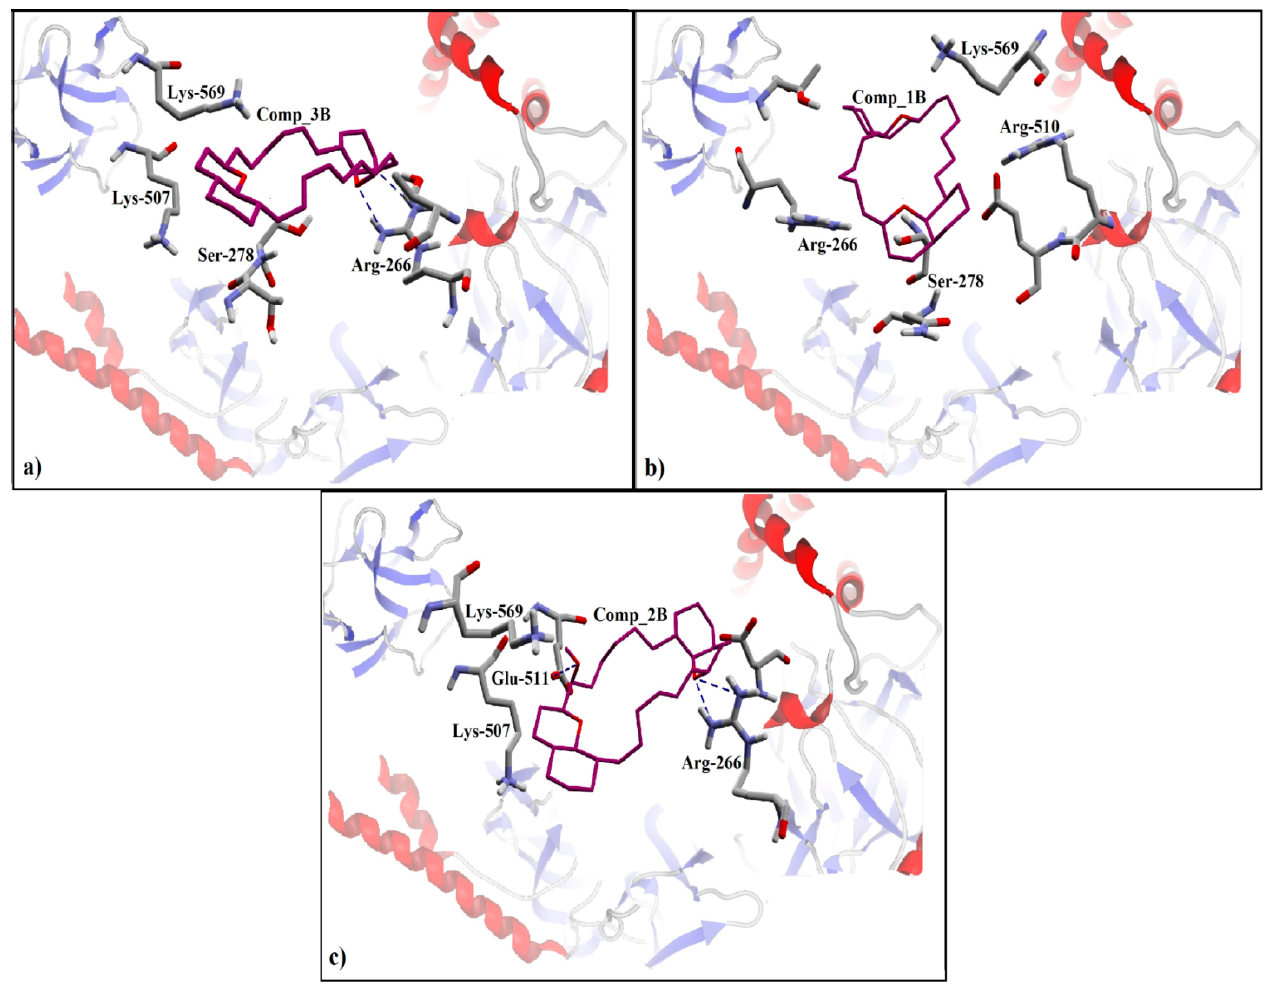
Figure 5. The ligand protein interactions of docking solutions of Class B in the binding pocket of IP 3 R. The back bone of protein is represented as a secondary structure. The interacting residues are shown in stick form with elements colors scheme. ( a ) The hydrogen bond interactions of a final docked pose of 3B with Arg-266. ( b ) Final docked pose of 1B showing the π – π interaction with Lys-507, and hydrophobic interaction (surface contact) with Arg-266. ( c ) 2B showing hydrogen bond interaction with Arg-266, and Glu-511.